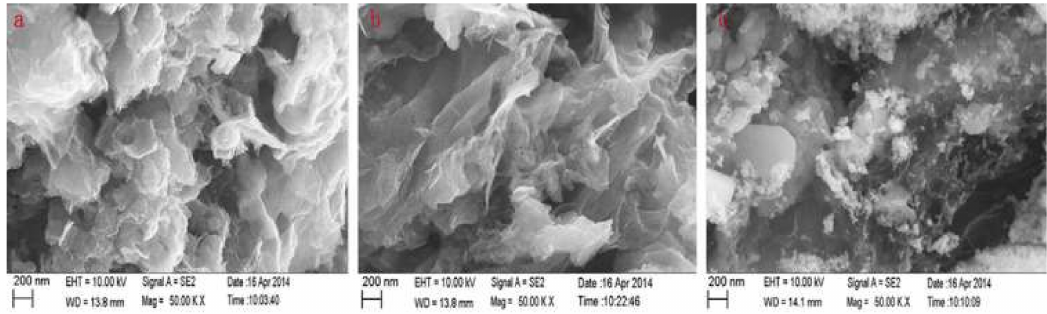
Figure 3. Scanning electron micrographs of reduced graphene oxide (RGO) / Fe 3 O 4 prepared by solvothermal ( a ), hydrothermal ( b ) and co-precipitation ( c ) methods. Reproduced with permission from [64]. Copyright Elsevier,